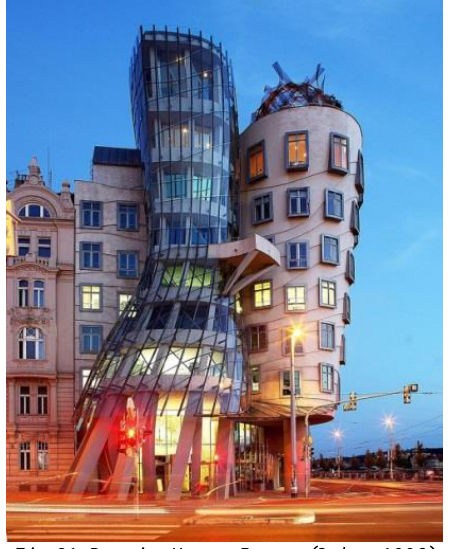
Fig. 31 Dancing House, Prague (Gehry,